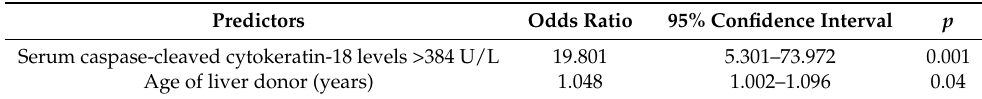
Table 2. Multiple logistic regression analysis for one-year mortality prediction in patients undergoing liver transplantation for hepatocellular